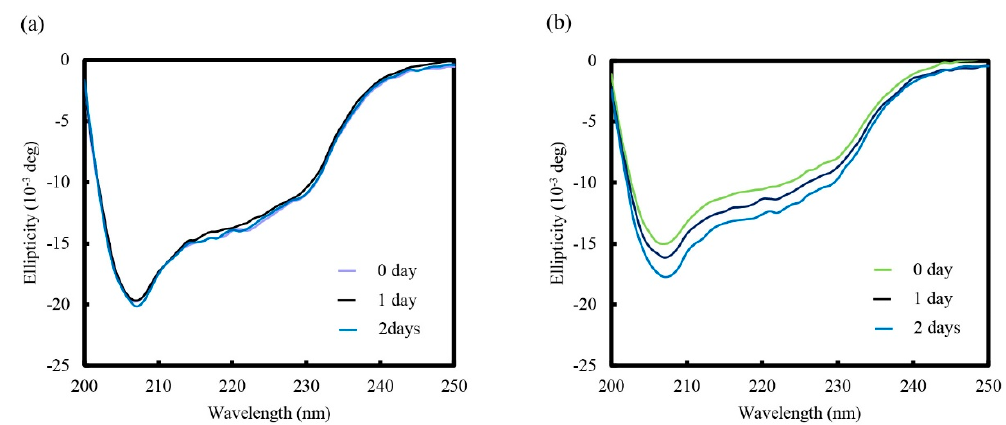
Figure 3. Change of circular dichroism (CD) spectra of lysozyme ( a ) and CHLysozyme ( b ) with time in the far UV (200 nm to 250 nm) region at 25 °C. Lysozyme and CHLysozyme concentration: 0.2 mg/mL.